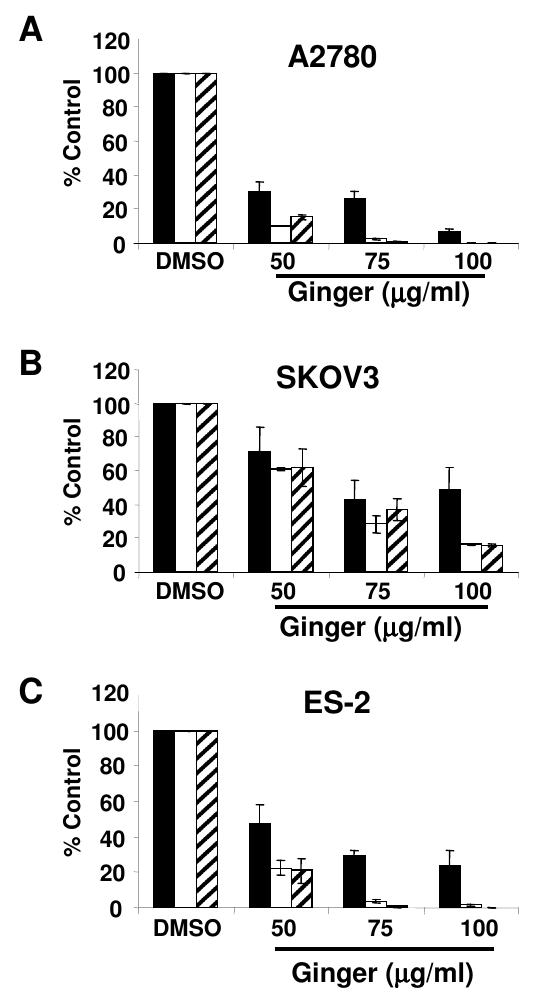
lines was assessed by using sulforhodamine B assays.